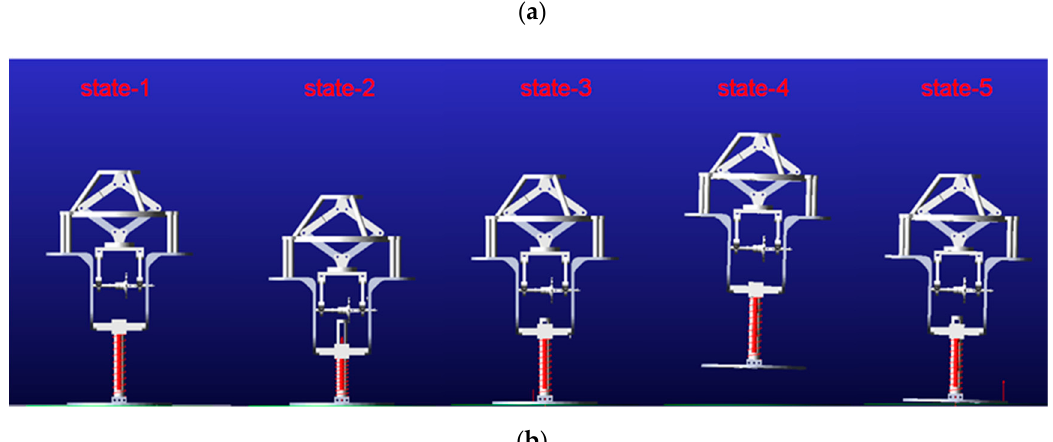
Figure 7. ( a ) The jumping heights of the robot for different k values. ( b ) The key positions of the jumping robot in the simulation.